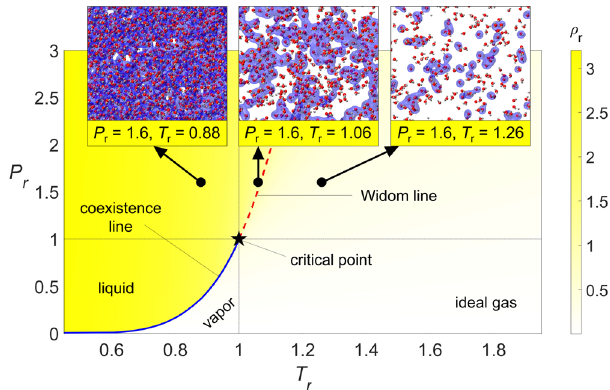
Fig.1|Phaseregimediagramforwater. TheWidomlineisshownasareddashed curve and the critical point is labeled with a black star. Insets show that clusters fragment as temperature is increased: from a liquid-like state ( T r =0.88), via the Widom line ( T r =1.06) to a gas-like state ( T r =1.26). These snapshots show the microscopic structure and clustering in MD simulations of supercritical water at P r =1.6; O atoms are represented in red and H atoms are represented in gray. The clusters, de fi ned using Hill ’ s criterion, are shaded in pale blue.